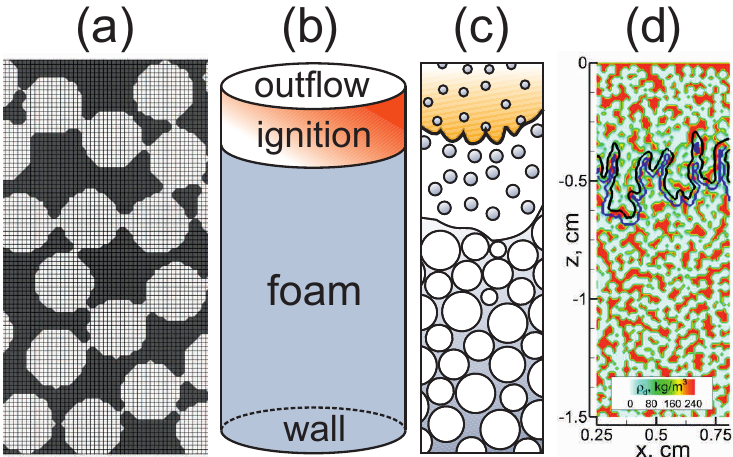
Figure 2. ( a ) The structure of the foam model: gray regions contain greater amount of liquid, white regions contain greater amount of gas, and grid corresponds to the numerical grid. ( b ) The geometry of computational domain: gray region—the foam at 300 K temperature, red region—the heated layer ( T = 3000 K). The height of the channel is 14 cm, the width of the channel varies from 0.25 cm to 3.7 cm. ( c ) Schematic pattern of the downward flame propagation process in the foam (the same as was reported previously in [30]). ( d ) Calculated spatial distribution of liquid phase density ρ d ; black line—the position of the flame front at the considered time instant, blue line—foam surface; channel width is 1